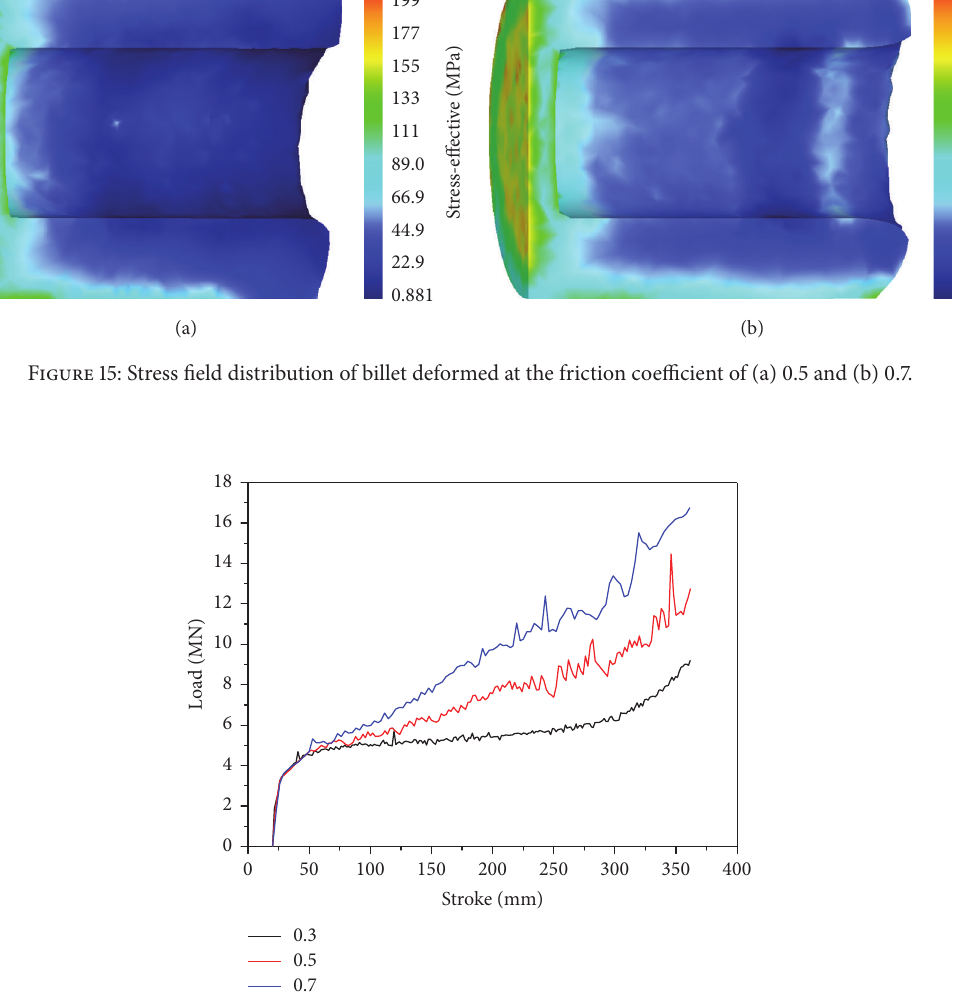
Figure 16: Effect of friction on the load-stroke